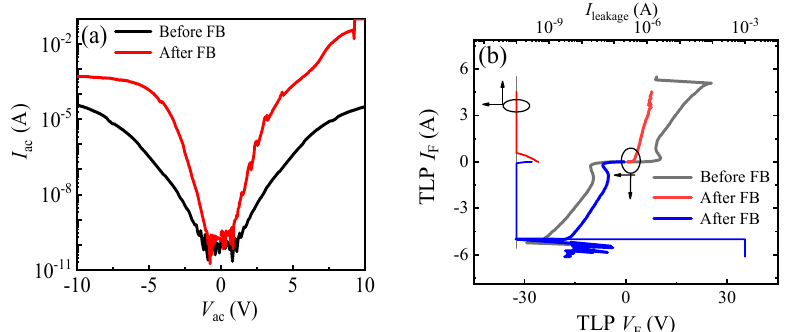
Figure 6. The bidirectional leakage current characteristics on a log-scale ( a ) and TLP I–V characteristics ( b ) before and after the forward ESD breakdown. The C GA ( C GC ) of the proposed AlGaN/GaN B-ESD-PD was 10 pF.